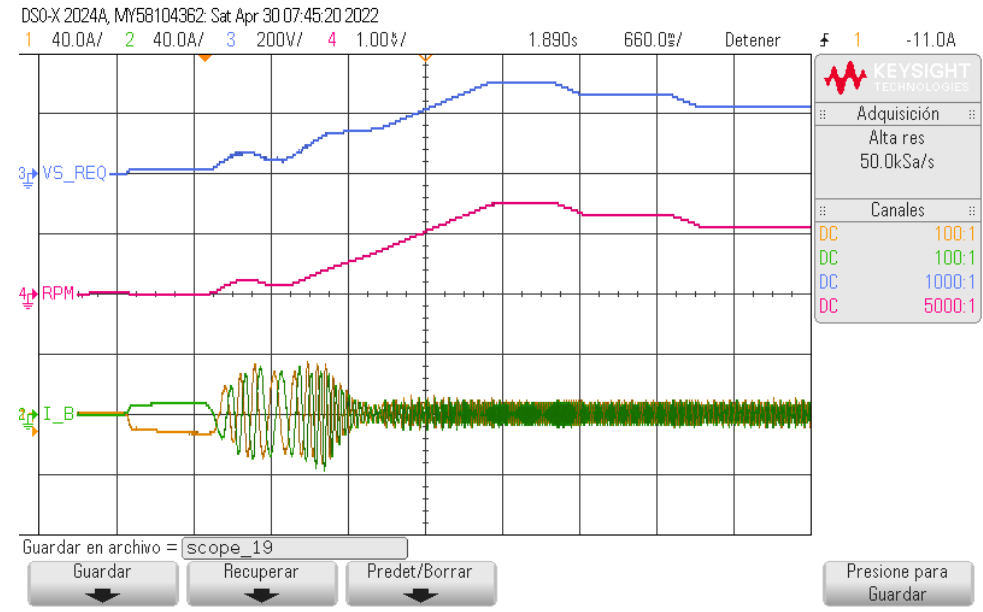
Figure 6. Oscilloscope waveforms of V ∗ s , ω r , and i a and i b , for the proposed